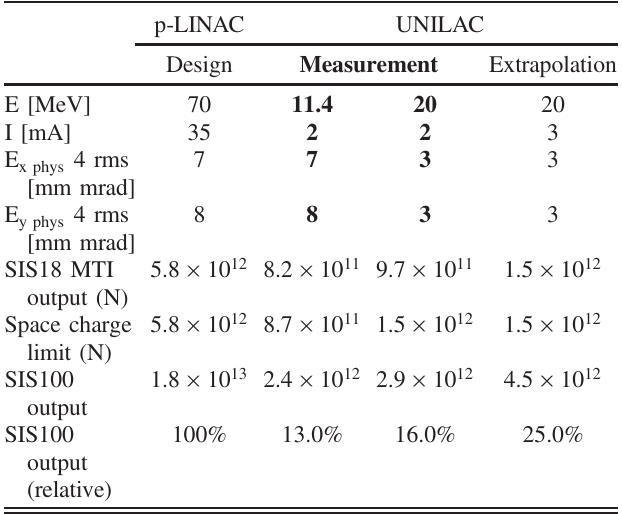
TABLE III. Comparison of estimated intensities for different FAIR proton injector options [7 – 9]. Measured data are marked in